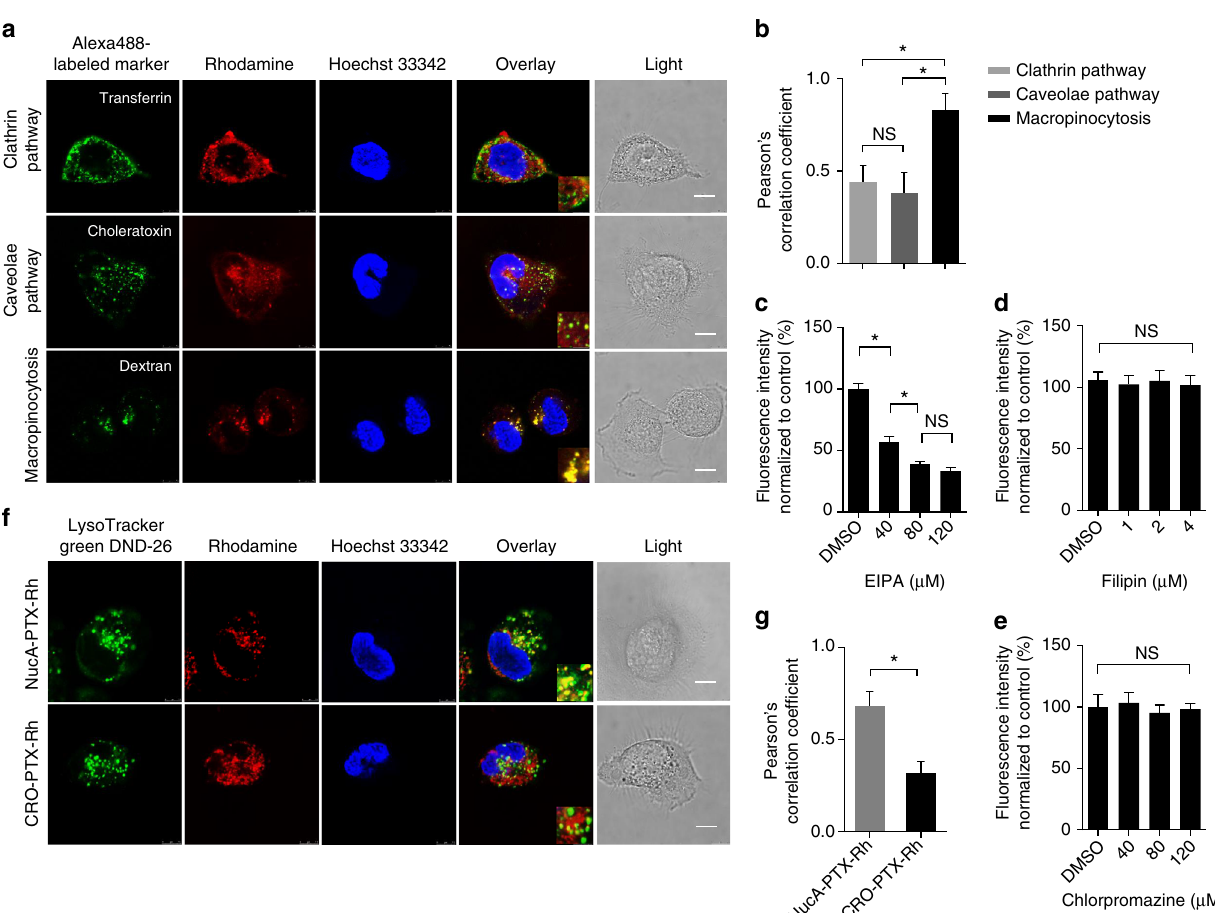
Fig. 4 The effect of NucA modi fi cation on cellular internalization and traf fi cking. a Representative images showing the co-localization of the conjugated PTX-Rh (red) in NucA-PTX-Rh with Alexa Fluor 488-labled endocytic markers (transferrin, choleratoxin and dextran; green) by confocal microscopy. The nuclei were counterstained with Hoechst 33,342 (blue). Scale bar, 10 μ m. b Pearson ’ s correlation coef fi cient analysis of the co-localization between NucA- PTX-Rh and endocytosis markers in SKOV3 cells by Image J Coloc2. Error bars indicate mean ± standard deviation. n = 5 per group. Each replicate is from one biological experiment, quanti fi ed with 10 independent fi elds of view. * P < 0.05; NS: not signi fi cant difference. c - e The chemical inhibition of cellular uptake for the conjugated PTX-Rh in CRO-PTX-Rh in SKOV3 cells. The relative fl uorescence of rhodamine was quanti fi ed after the treatment with inhibitors of three endocytic pathways by fl ow cytometry: EIPA (macropinocytosis, c ), Filipin (caveolae pathway, d ), and Chlorpromazine (clathrin pathway, e ). Error bars indicate mean ± standard deviation. n = 3. * P < 0.05; NS: not signi fi cant difference. f Representative images showing the co-localization of the conjugated PTX-Rh (red) with a lysosomal marker (LysoTracker Green DND-26; green) by confocal microscopy. The nuclei were counterstained with Hoechst 33,342 (blue). Scale bar, 10 μ m. g Pearson ’ s correlation coef fi cient analysis of the co-localization between the conjugates and lysotracker in SKOV3 cells by Image J Coloc2. The data were presented as the means ± standard deviation. n = 5 per group. Each replicate is from one biological experiment, quanti fi ed with 10 independent fi elds of view. * P <